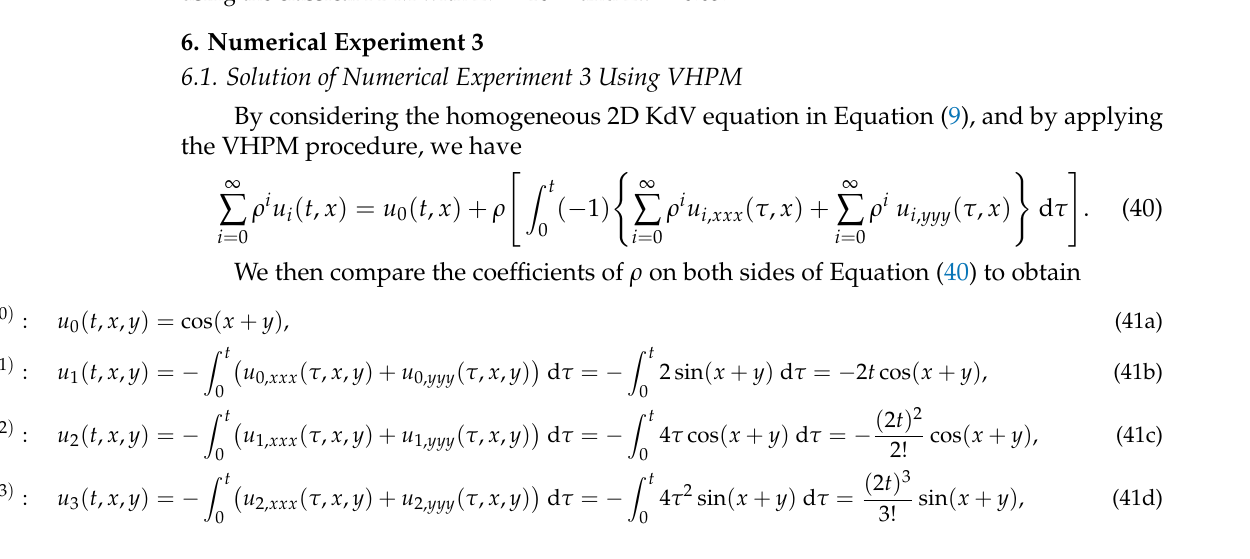
Figure 12. Plots of the maximum error vs. time t ∈ [ 0,2.0 ] , and the loglog plot of max. error vs. time, using the classical FDM with ∆ t = 10 − 5 and ∆ x =